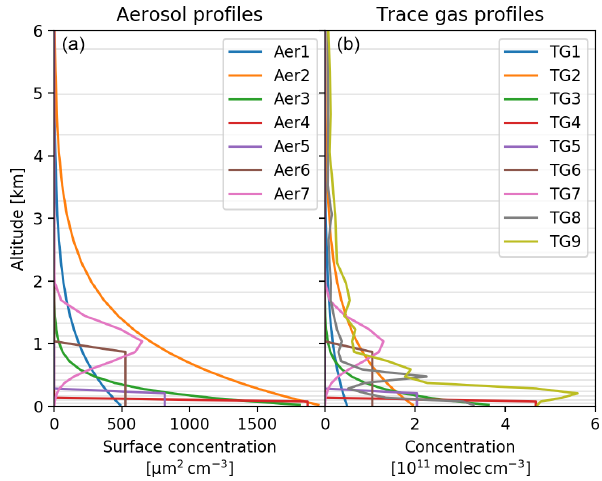
Figure 2. Aerosol area concentrations (a) and trace gas concentra- tions ( b , same profiles for HCHO and NO 2 ) vertical profiles used as input for the forward modelling of synthetic data (see also Table